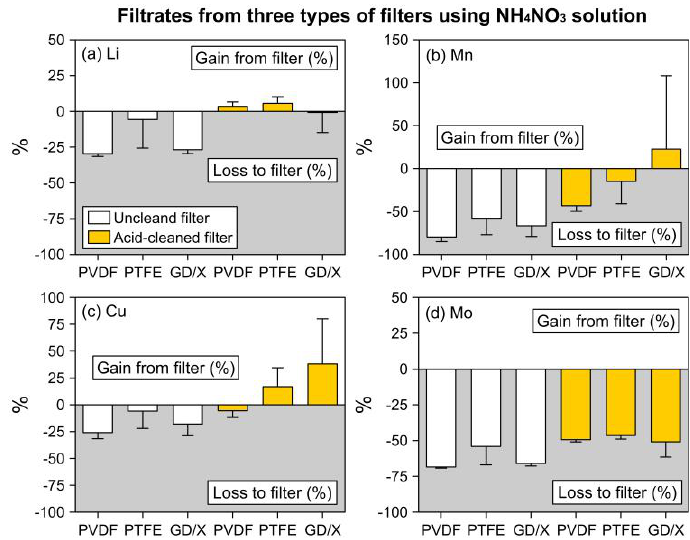
Figure 1. Average percent gains (white zone) from the filters or losses (grey zone) to the filters of trace elements in NH 4 NO 3 solution passing through uncleaned and acid-cleaned membrane filters of three materials (PVDF, PTFE, and GD/X), compared to those in the primary solution. Error bars represent standard deviation (SD). PVDF, polyvinylidene difluoride; PTFE, polytetrafluoroethylene; GD/X, glass microfiber prefiltration media.